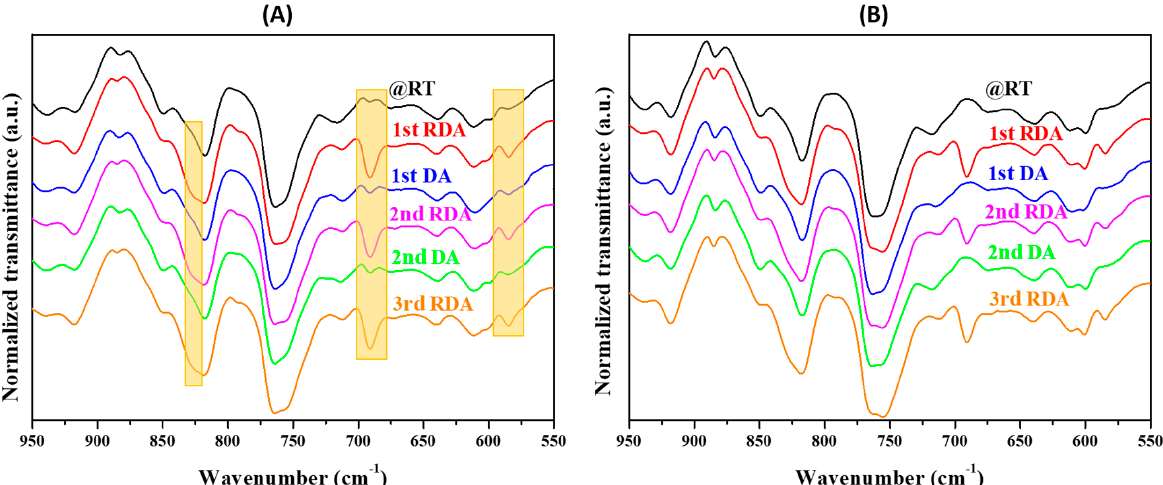
Figure 9. ATR-FTIR spectra showing the evolution of the flexible BMI signal at different thermal treatments for the samples PURSF-04 ( A ) and PURSF-08 ( B ) with 12%TB. The orange boxes correspond to regions where deformation modes characteristic of BMIF appear.